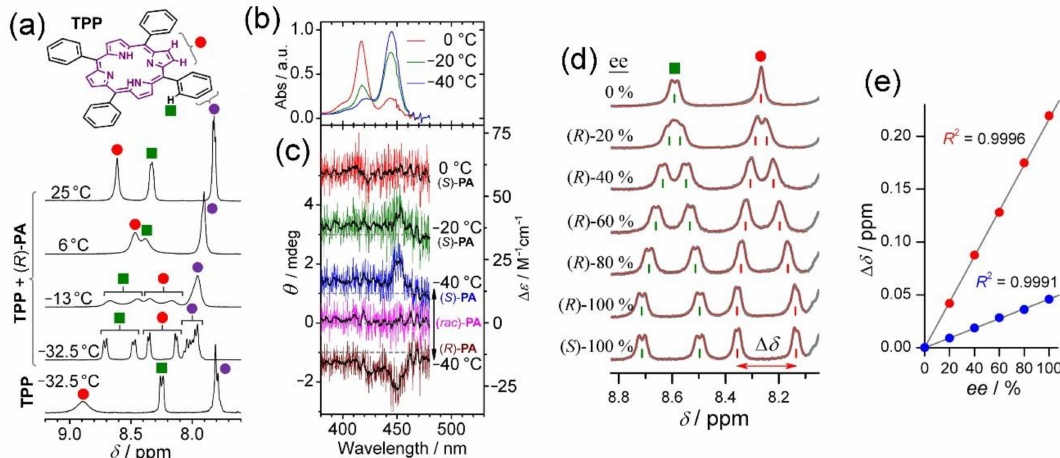
Figure 5. ( a ) 1 H-NMR spectra of TPP in CDCl 3 with 8 equivalents ( R )-2-phenoxypropionic acid (( R )- PA ) collected while cooling to –32.5 ◦ C (lowest trace shows TPP only). A spectrum of TPPH 42+ (at –32.5 ◦ C: TPP + ( R )- PA ) differs significantly from free TPP at –32.5 ◦ C. ( b ) UV-vis spectra of TPP / TPPH 42+ with excess (500 eq.) ( S )- PA on cooling to − 40 ◦ C. Absorption at 445 nm due to porphine dication increases on cooling. ( c ) Circular dichroism (CD) spectra of TPPH 42+ with excess (500 eq.) ( S )- PA during cooling (top 3 traces) and with (500 eq.) ( S )- PA , ( rac )- PA , and ( R )- PA at − 40 ◦ C (bottom 3 traces). ( d ) Partial 1 H-NMR spectra of the TPPH 42+ aromatic region (–32.5 ◦ C) in the presence of various ee of ( R )- PA used to estimate ∆ δ . ( e ) Dependency of ∆ δ on ee for the porphine β -H resonances of TPP in the presence of PA (red) or Ibuprofen (blue) showing a linear relationship. Adapted with permission from Ref. [73]. Copyright 2011 John Wiley and